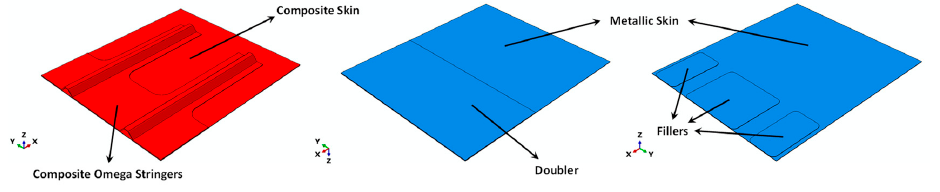
Figure 10. Bonded regions.